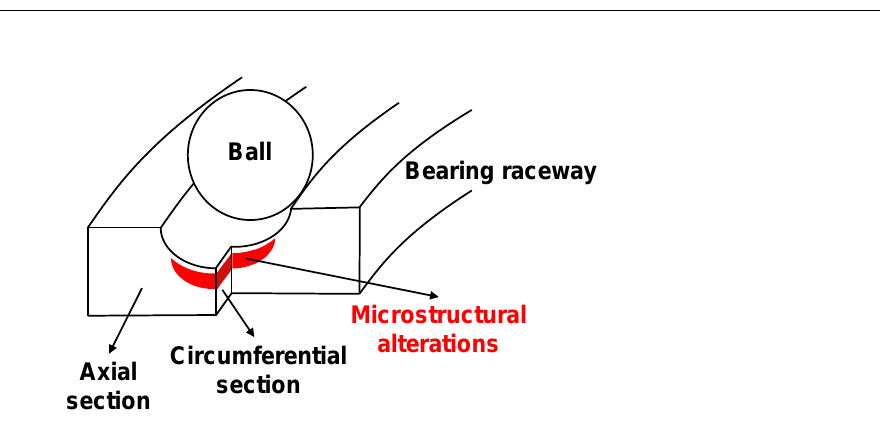
Figure 2. Sections of a bearing raceway where microstructural alterations are usually